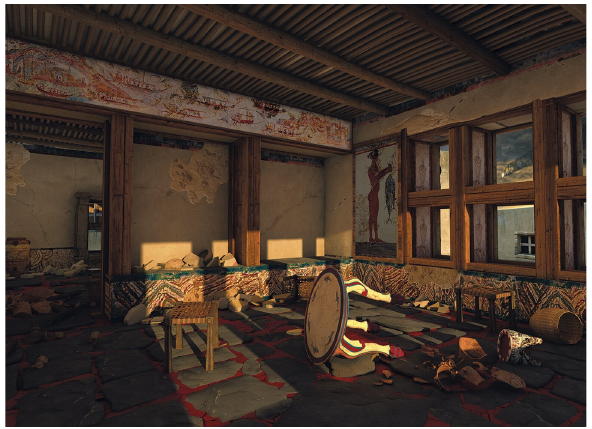
Figure 10: 3D virtual architectural suggestion superimposed onto a present day view of the Westhouse at Akrotiri’s Triangle square. Such an augmented visualisation could help visitors to better un- derstand and experience the former splendor of this town.